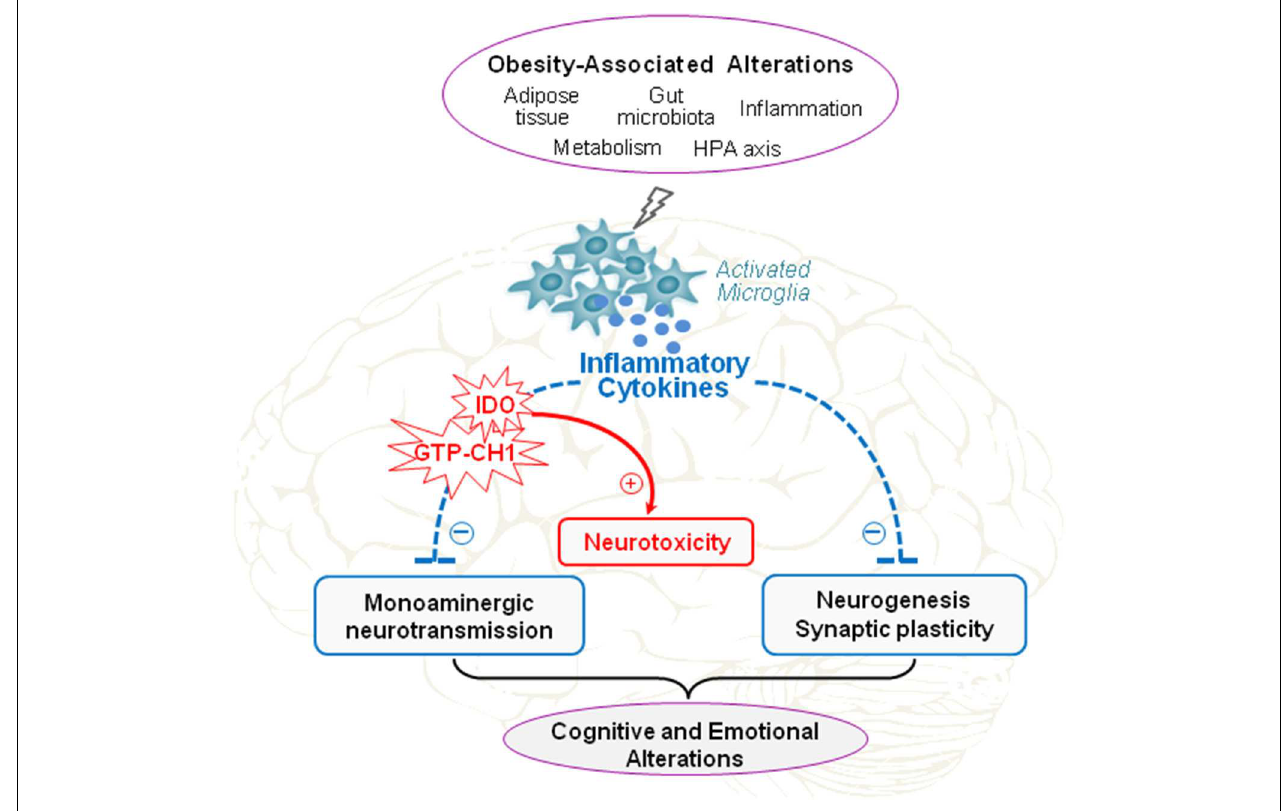
FIGURE 3 | Proposed role of neuroinflammation in obesity-associated cognitive and emotional alterations. Obesity is characterized by metabolic alterations (hyperinsulinemia, hyperleptinemia, increased activation of the hypothalamo-pituitary-adrenal (HPA) axis…) and peripheral low-grade inflammation, which originates from alterations in adipose tissue and gut functions. These obesity-associated alterations are well-known to promote brain inflammatory processes that represent key players in the development of behavioral alterations associated with obesity. By sustaining